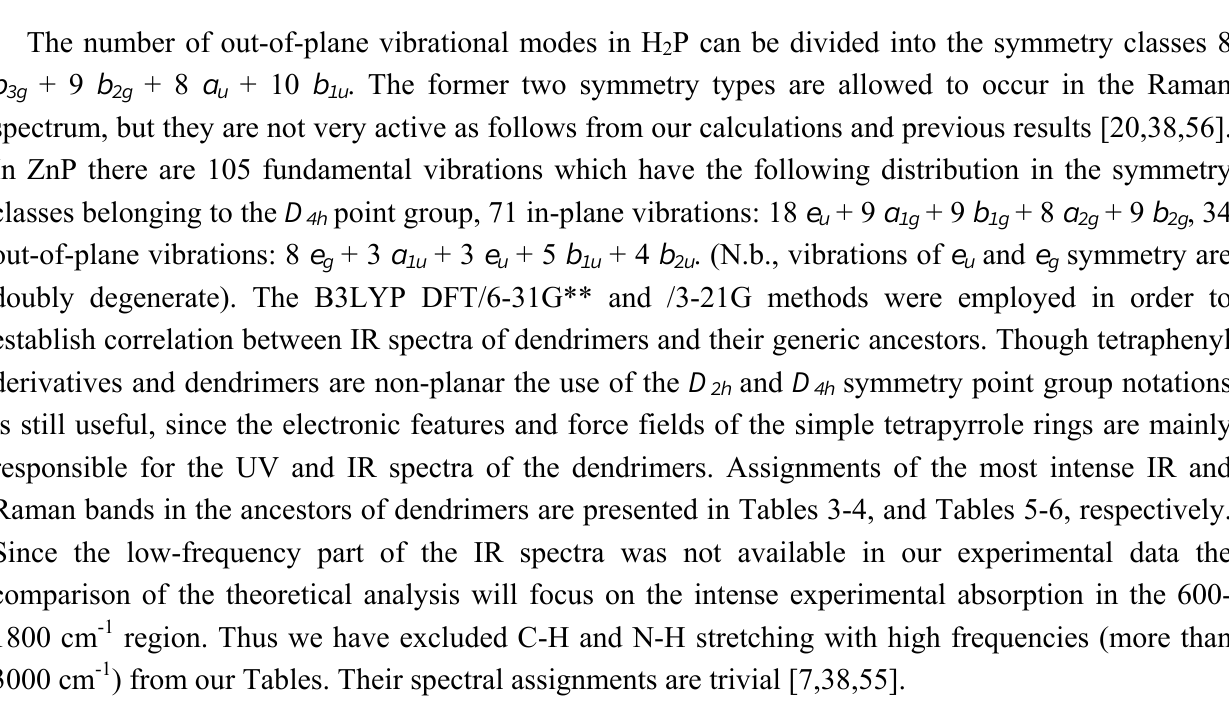
“ the wavenumber (cm -1 ). i 6-31G** Scaled 6-31G* (this work)